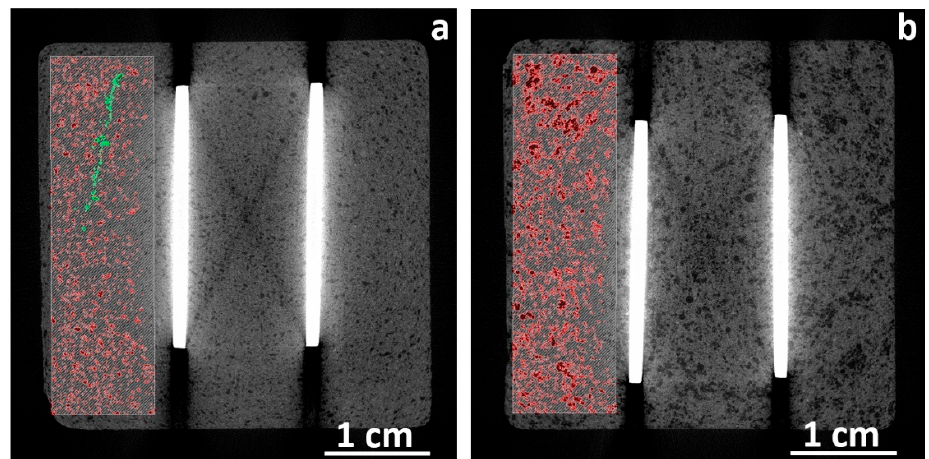
Figure 2. X-ray tomography cross-sections through samples K1 ( a ) and K2 ( b ). The red spots at the left side of the images indicate carbon nanofiber aggregates. The green pattern on figure ( a ) represents a fracture present in the material. Materials 2020 , 13 , x FOR PEER REVIEW